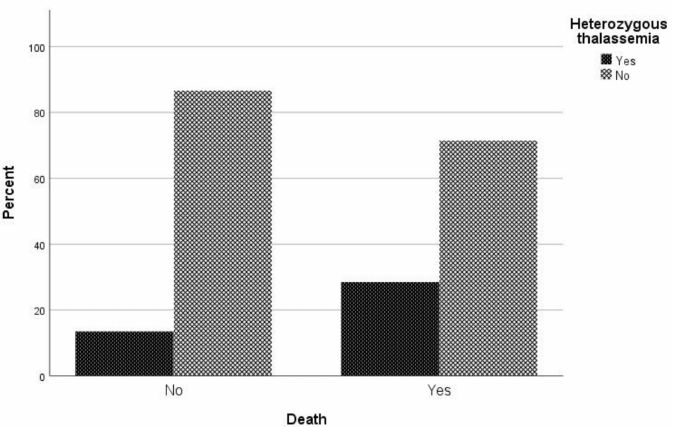
Figure 2. Proportion of β -thalassemia heterozygotes relative to non-carriers regarding mortality due to COVID-19.